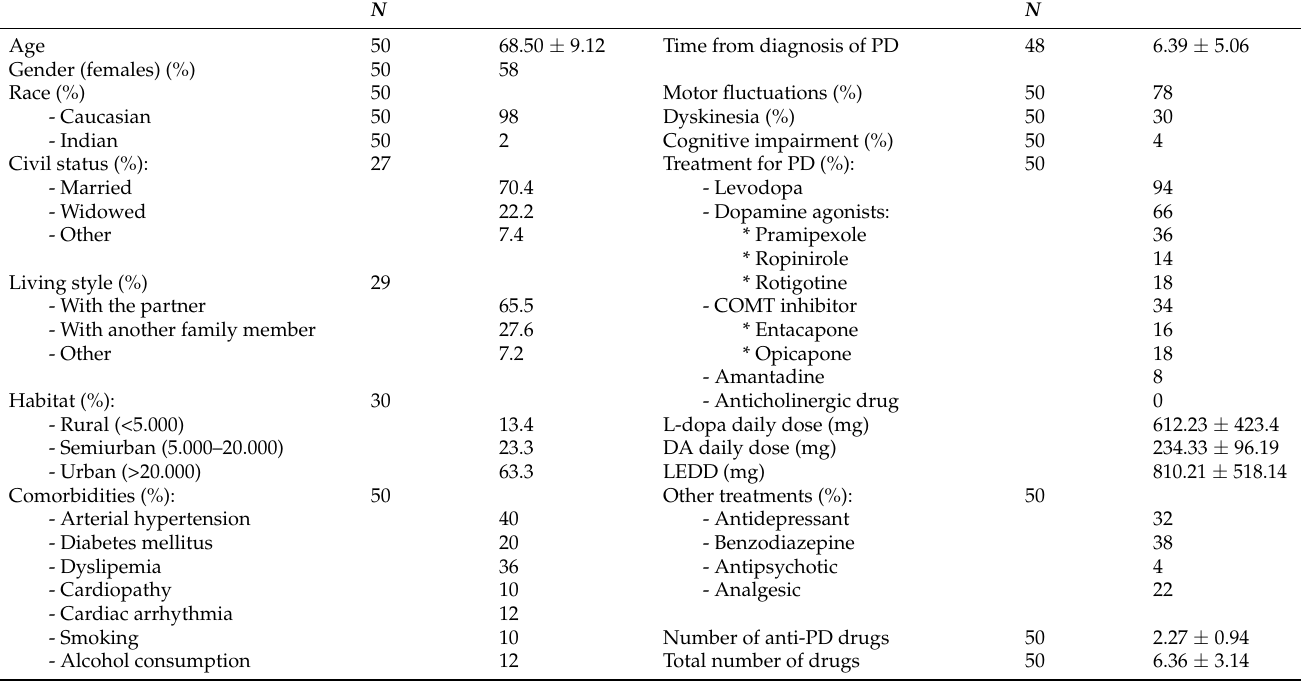
Table 1. Data about sociodemographic aspects, comorbidities, antiparkinsonian drugs and other therapies at